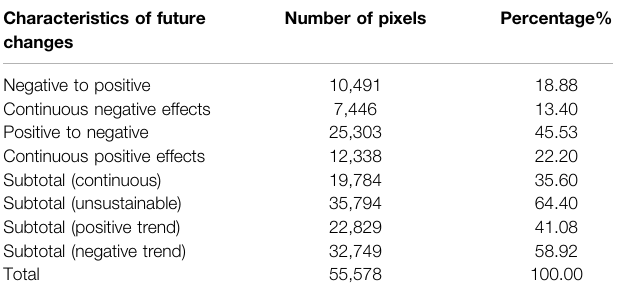
TABLE 2 | Statistical table summarizing the future trend in the effects of anthropogenic factors on vegetation cover in Guanzhong, Central